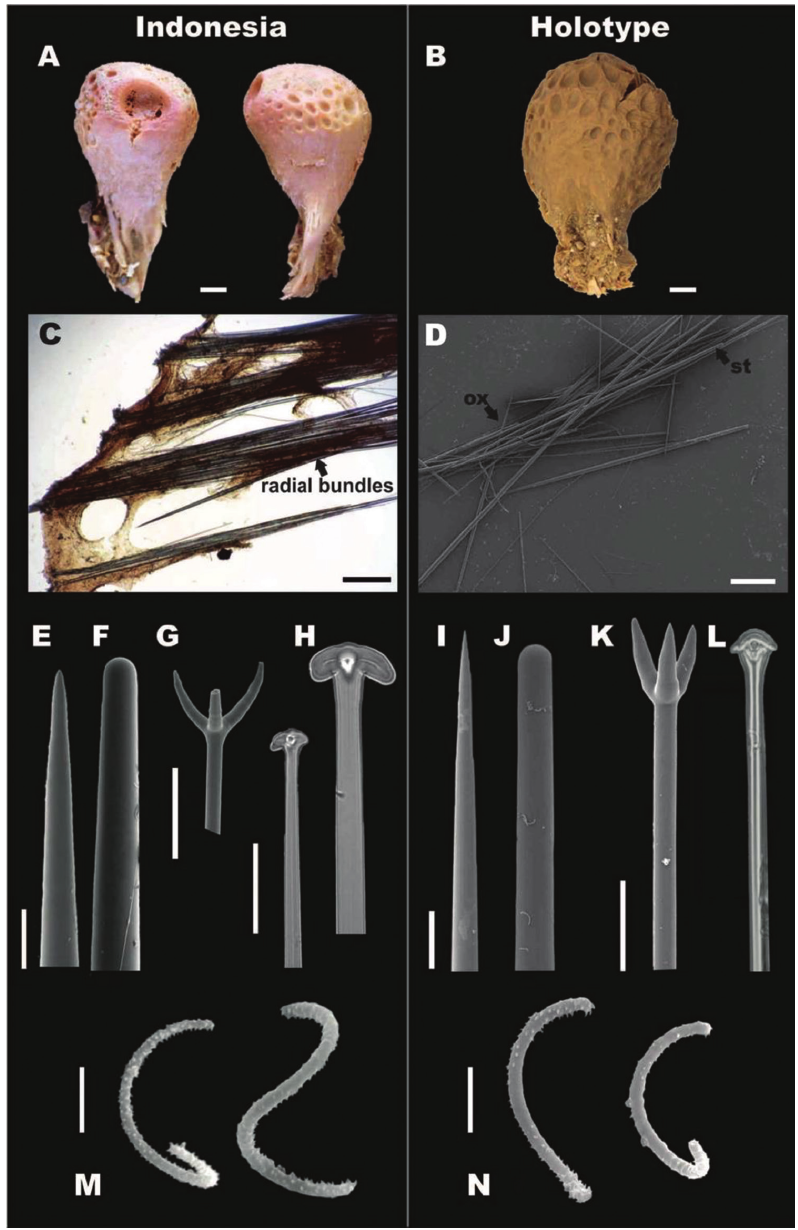
Figure 12. Cinachyrella paterifera . A, C, E-H, M RMNH.POR.11207, Berau Reef, Indonesia (left side). B, D, I-L, N holotype USNM 21314, Timundao Reef, Sulu Archipelago, Philippines (right side) A speci- men recently collected showing typical pink color, porocalices and stalk B Holotype, showing porocalices and stalk C skeleton showing radial bundles D spicules showing oxeas (ox) and strongyle (st), (scale bar 500 µm); E oxea, end detail F strongyle, end detail G protriaene H anatriaenes with short or abnormal cladus I oxea, end detail J strongyle, end detail K protriaenes L anatriaene with short or abnormal cladus M, N sigmaspires. Scale bars: 1 cm ( A, B ); 500 µm ( C, D ); 40 µm ( E–L ); 5 µm ( M, N